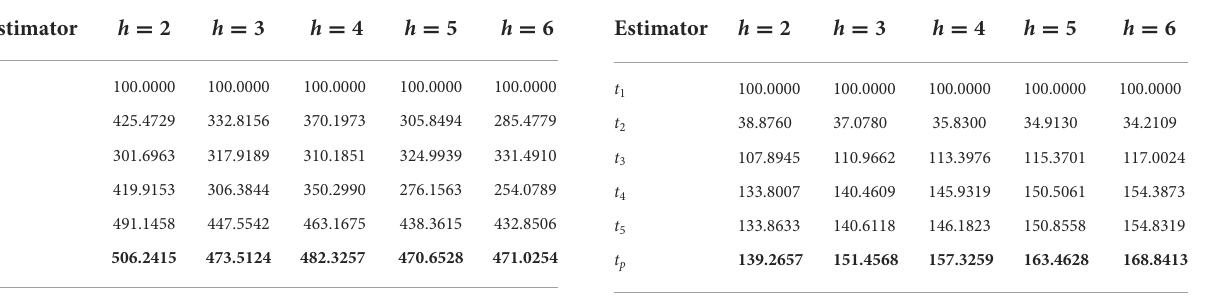
TABLE 2 Percentage relative efficiency (PRE) of different estimators with respect to t 1 for Population 1.